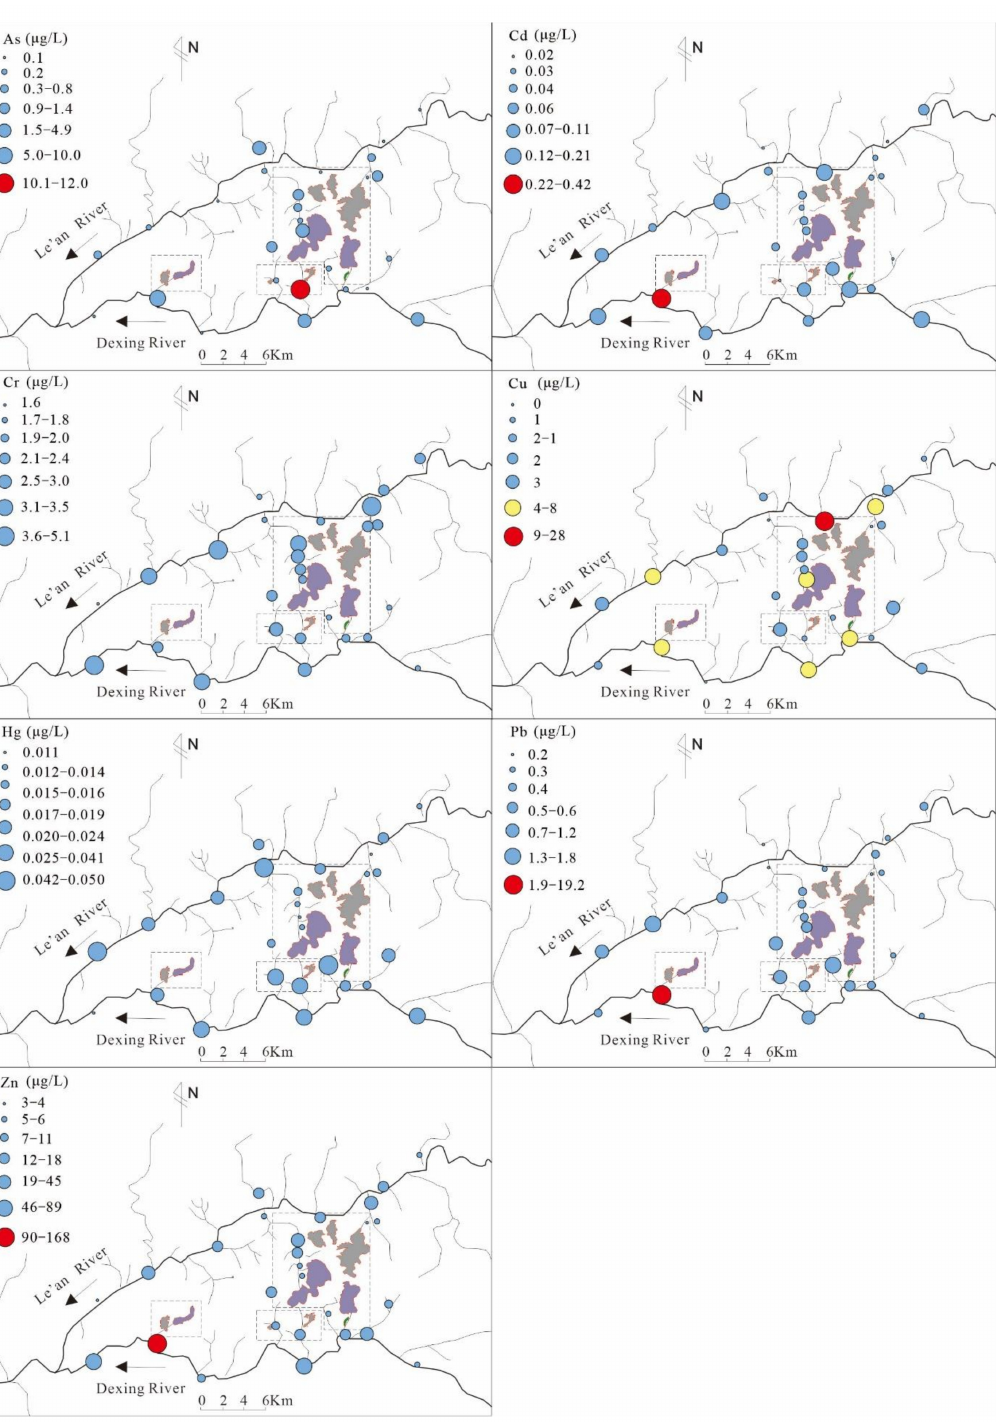
Figure 3. HMs distribution in ground water